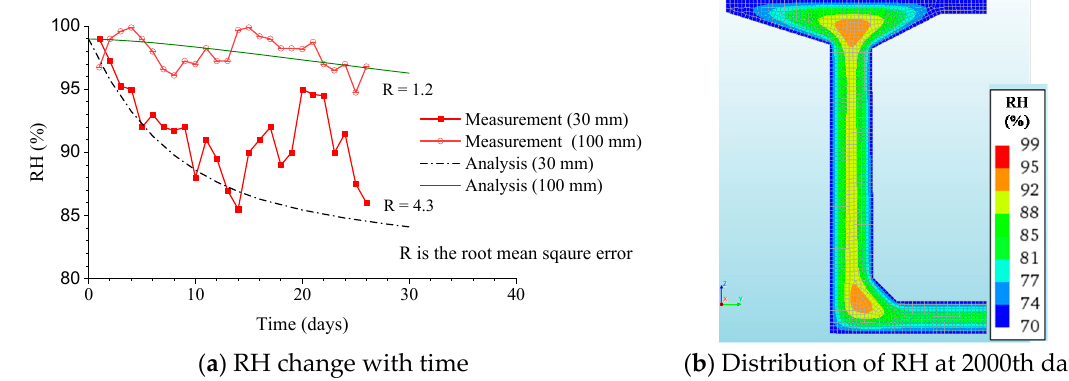
Figure 3. Comparison of relative humidity change with time and distribution of relative humidity at the mid-span of cantilever section.